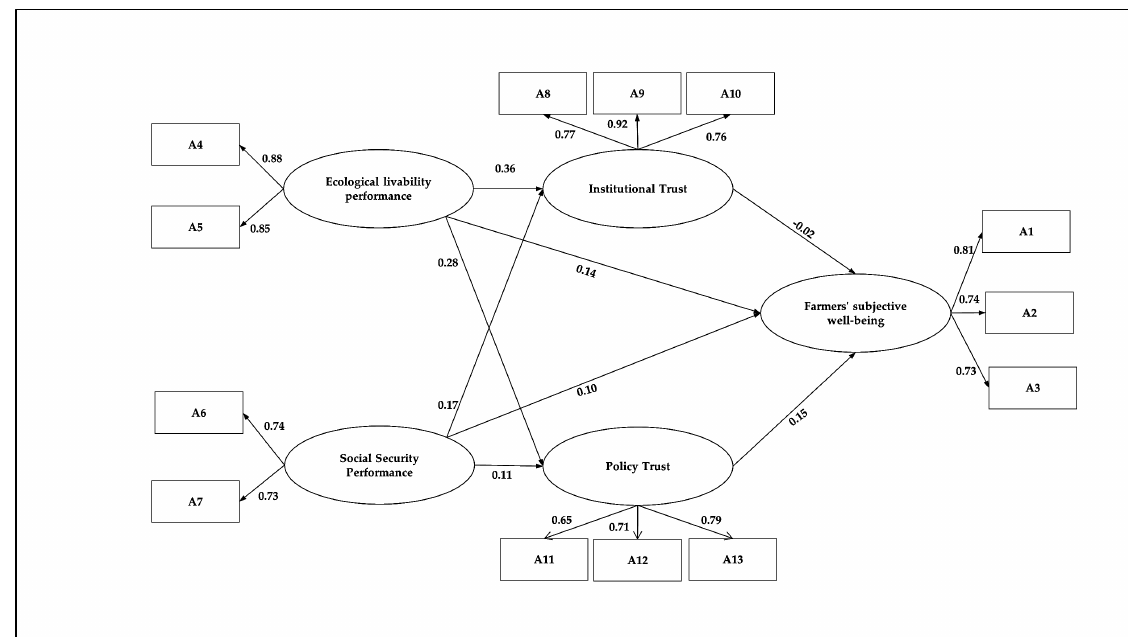
Figure 2. Complete results of SEM frameworks.